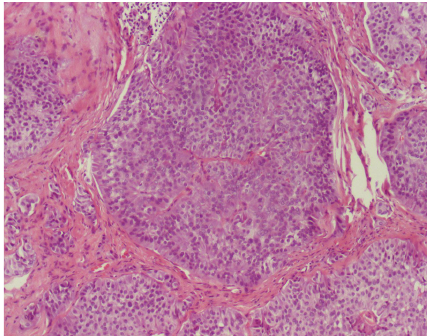
Figure 2: Resected specimen showing uniform neuroendocrine cells.